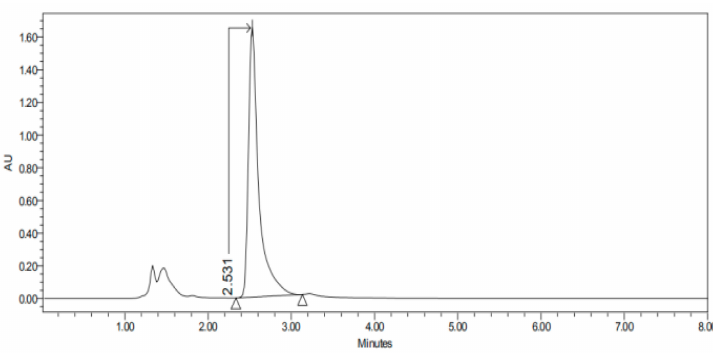
Figure 6. Chromatogram of CP-NPs in sublingual mucous at 6 h.